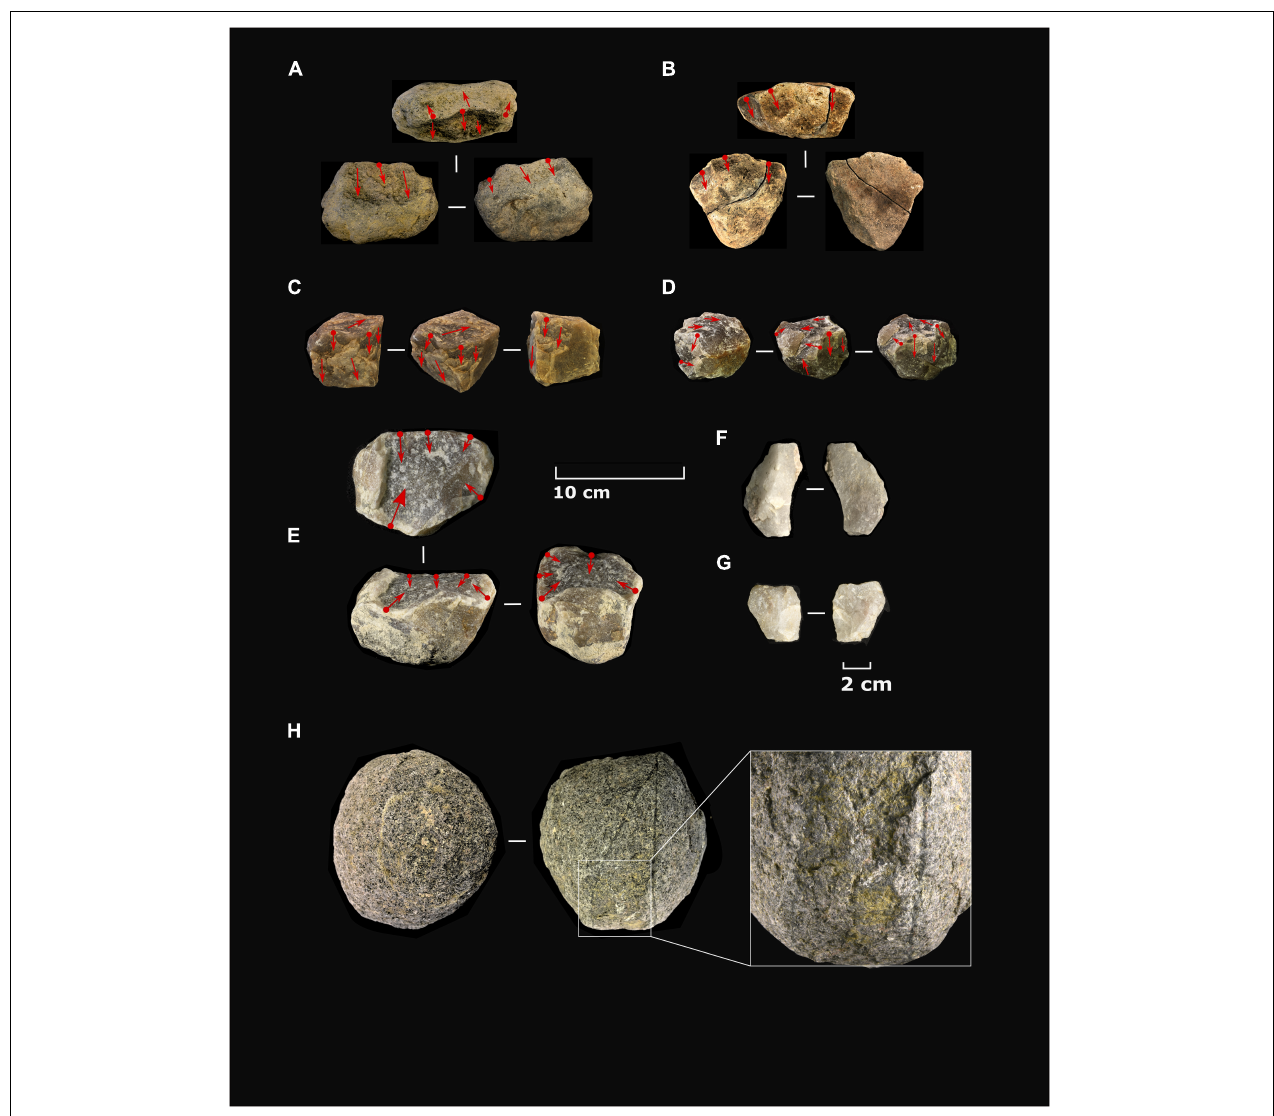
FIGURE 3 | Selection of stone tools from Phase II. (A) Ignimbrite chopping tool with technical schemes. (B) Ignimbrite chopper with technical schemes. (C) Quartzite unipolar longitudinal core with technical schemes. (D) Quartzite multipolar multifacial core with technical schemes. (E) Quartzite unifacial centripetal core with technical schemes. (F,G) Quartzite flakes. (H) Basalt percussive material. Detail shows impact marks on the surface. Red arrows indicate the directions of flake’s